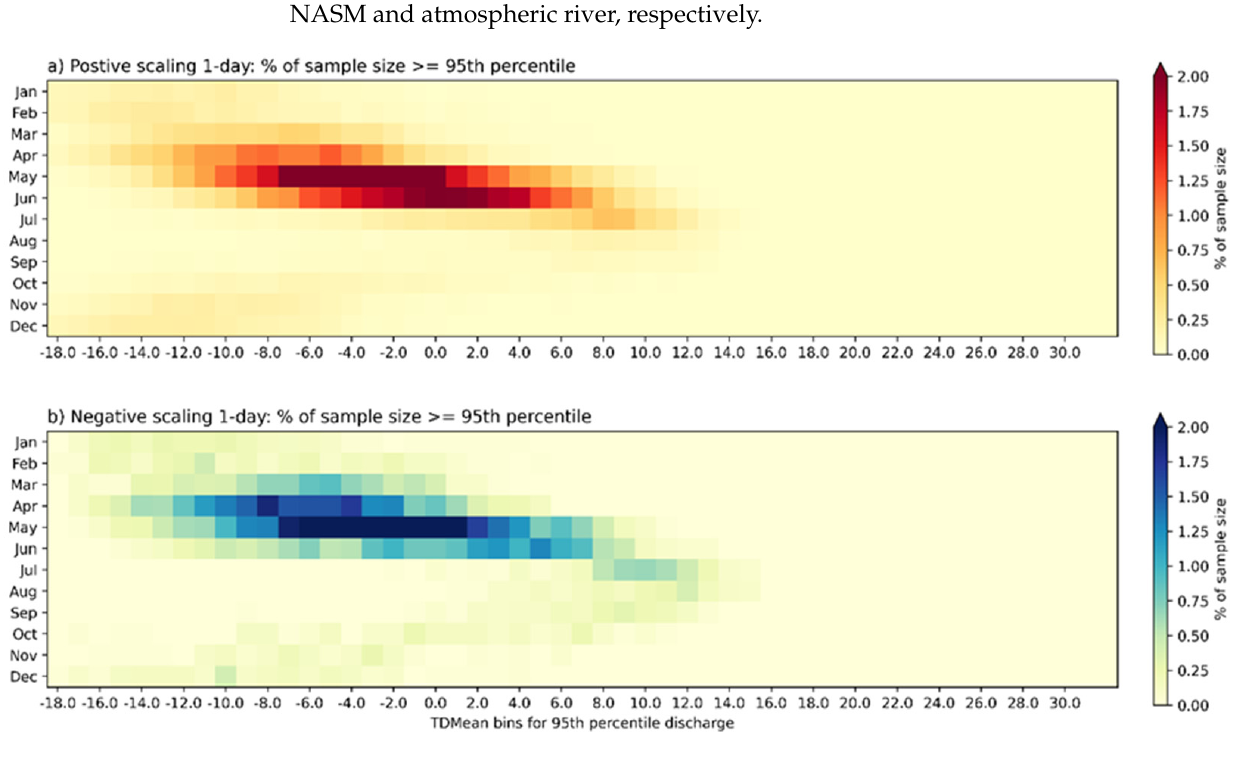
Figure 4. Monthly distribution of sample size of scaling by PRISM daily mean temperature with at least 95th percentile of discharge ( a ) for positive scaling with discharge and ( b ) negative scaling with discharge.